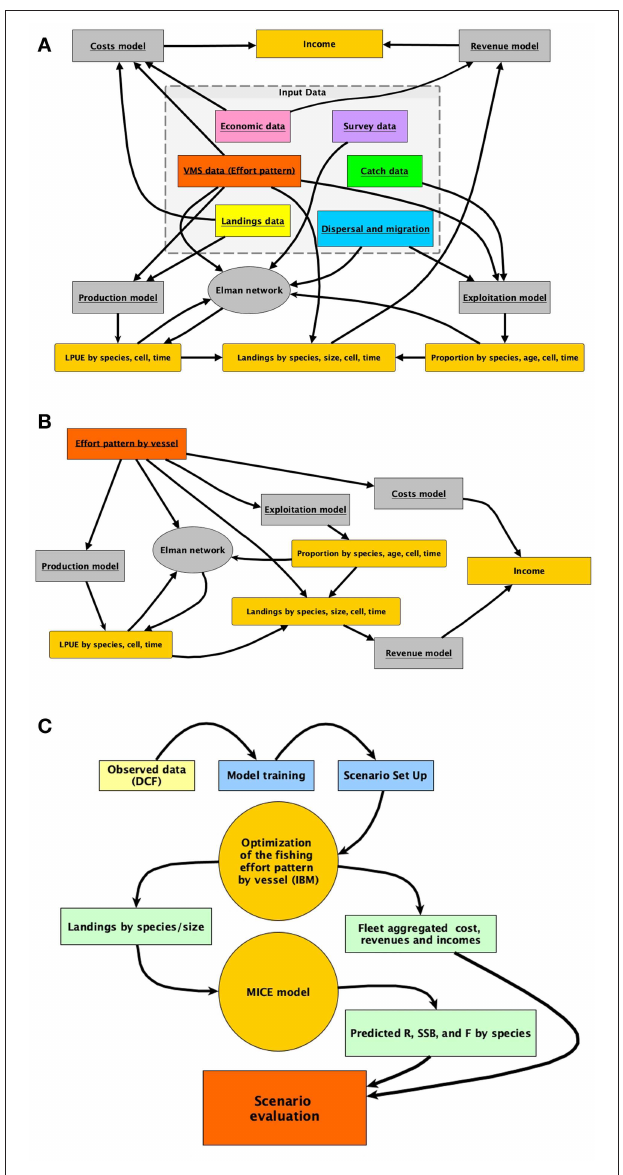
FIGURE 2 | Representation of (A) the architecture of the smartR model, showing as the different input data are processed by different modules; (B) summary of the IBM implemented to obtain the economic quantities to be optimized in relation to the effort pattern of each vessel; (C) the typical workflow, from DCF data to the final MSE